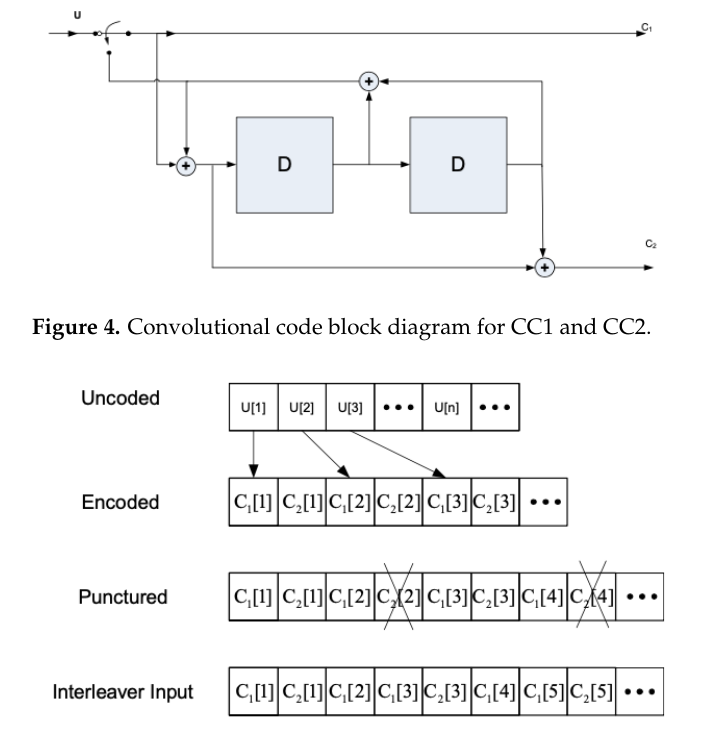
Figure 5. CC1 parity decimation puncturing